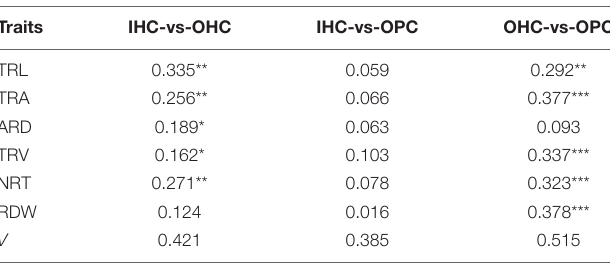
TABLE 3 | Correlation coefficients of root traits between the growing environments.